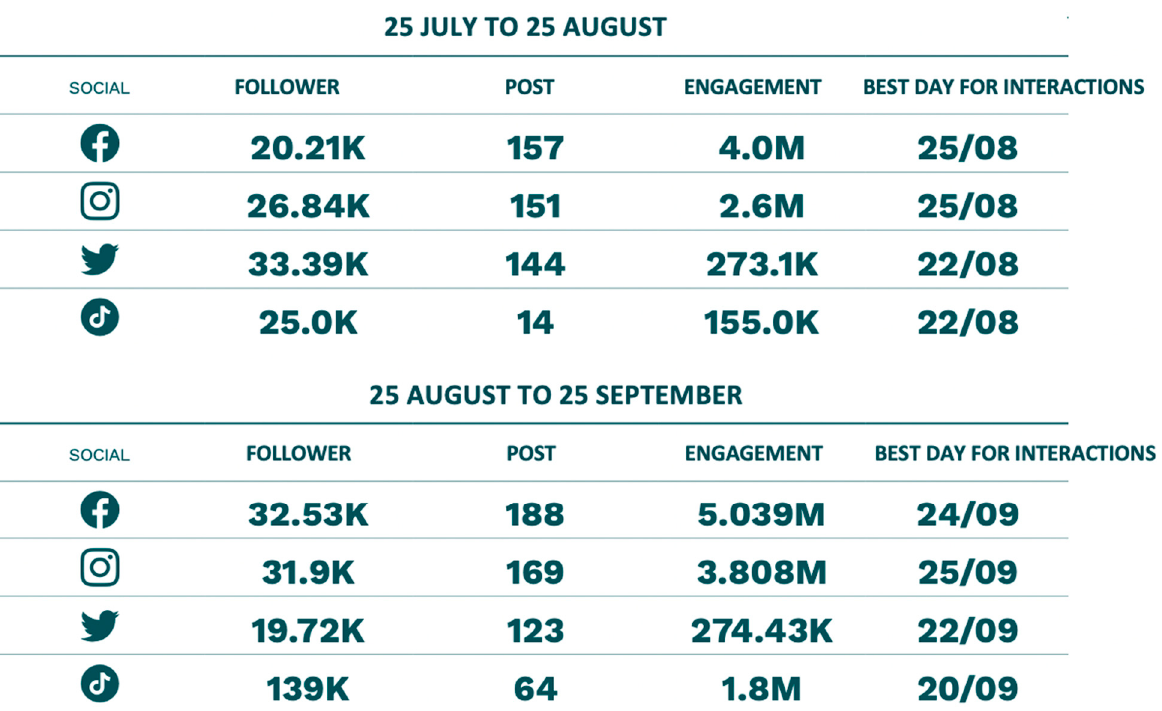
Figure 9. Automatic scanning by the tool Liveinsights-blogmeter. Reference period: July 2022– September 2022.